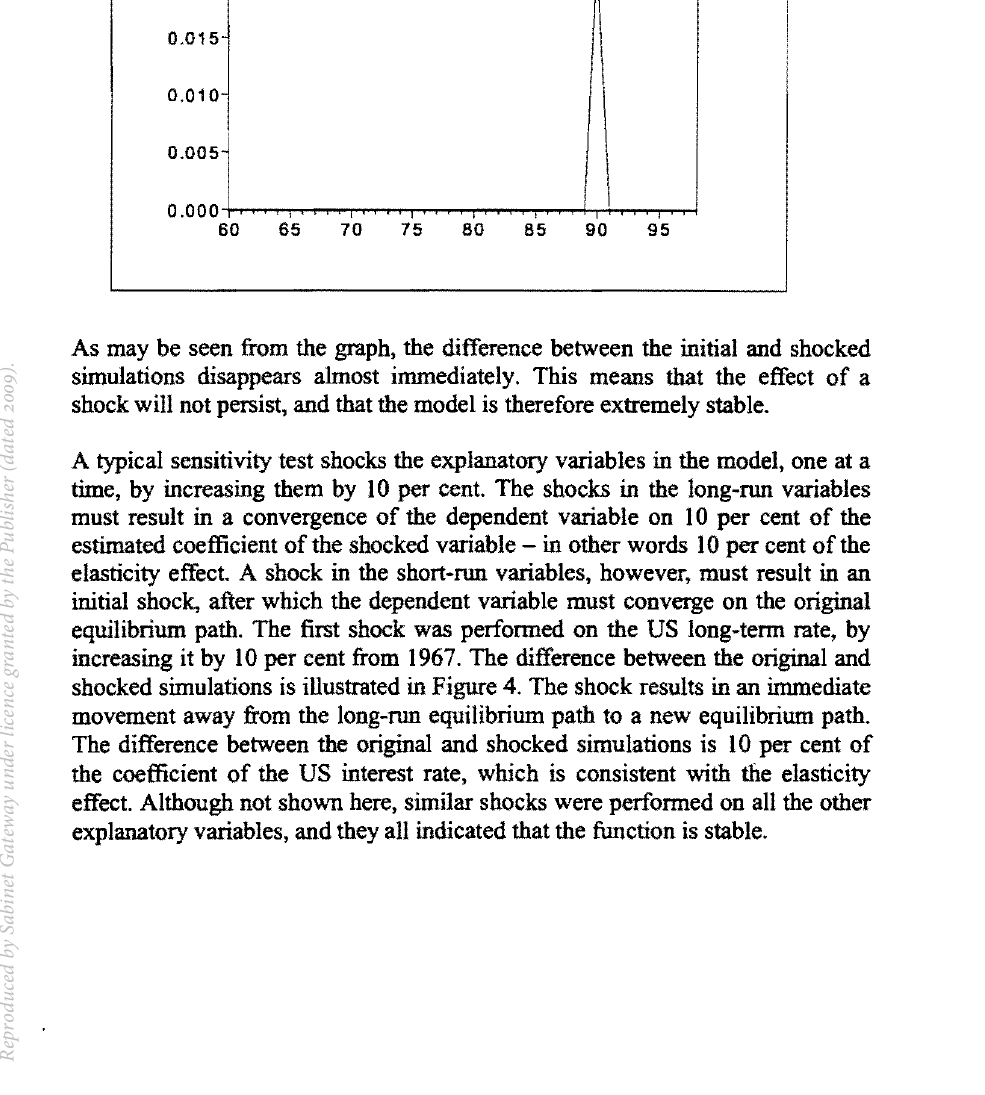
Figure 3 Difference between sbocked and original simulated interest rates wben a stability test is performed on tbe US interest